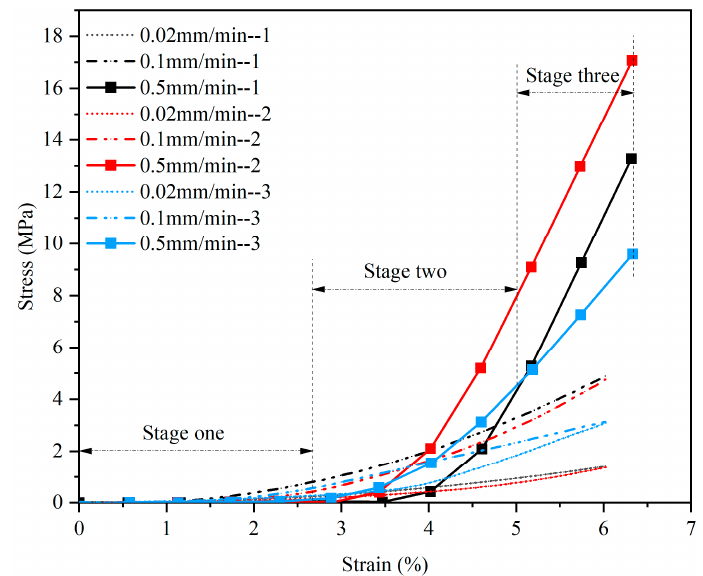
Figure 8. Stress–strain curves of uniaxial compression test.